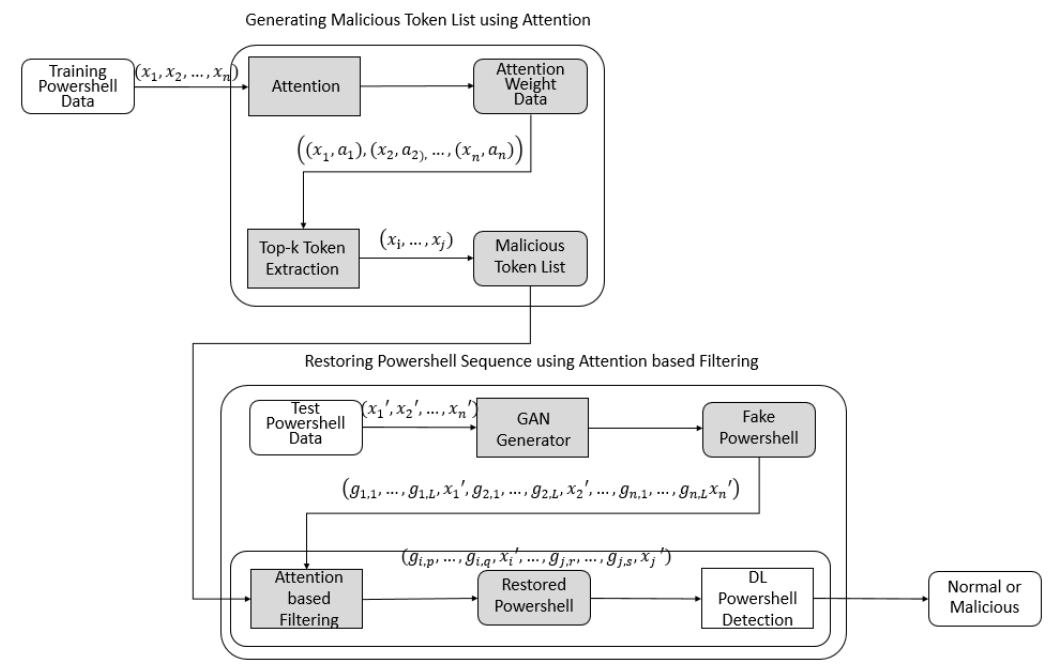
Figure 5. Malicious Token List Generation and Attention-based Filtering.